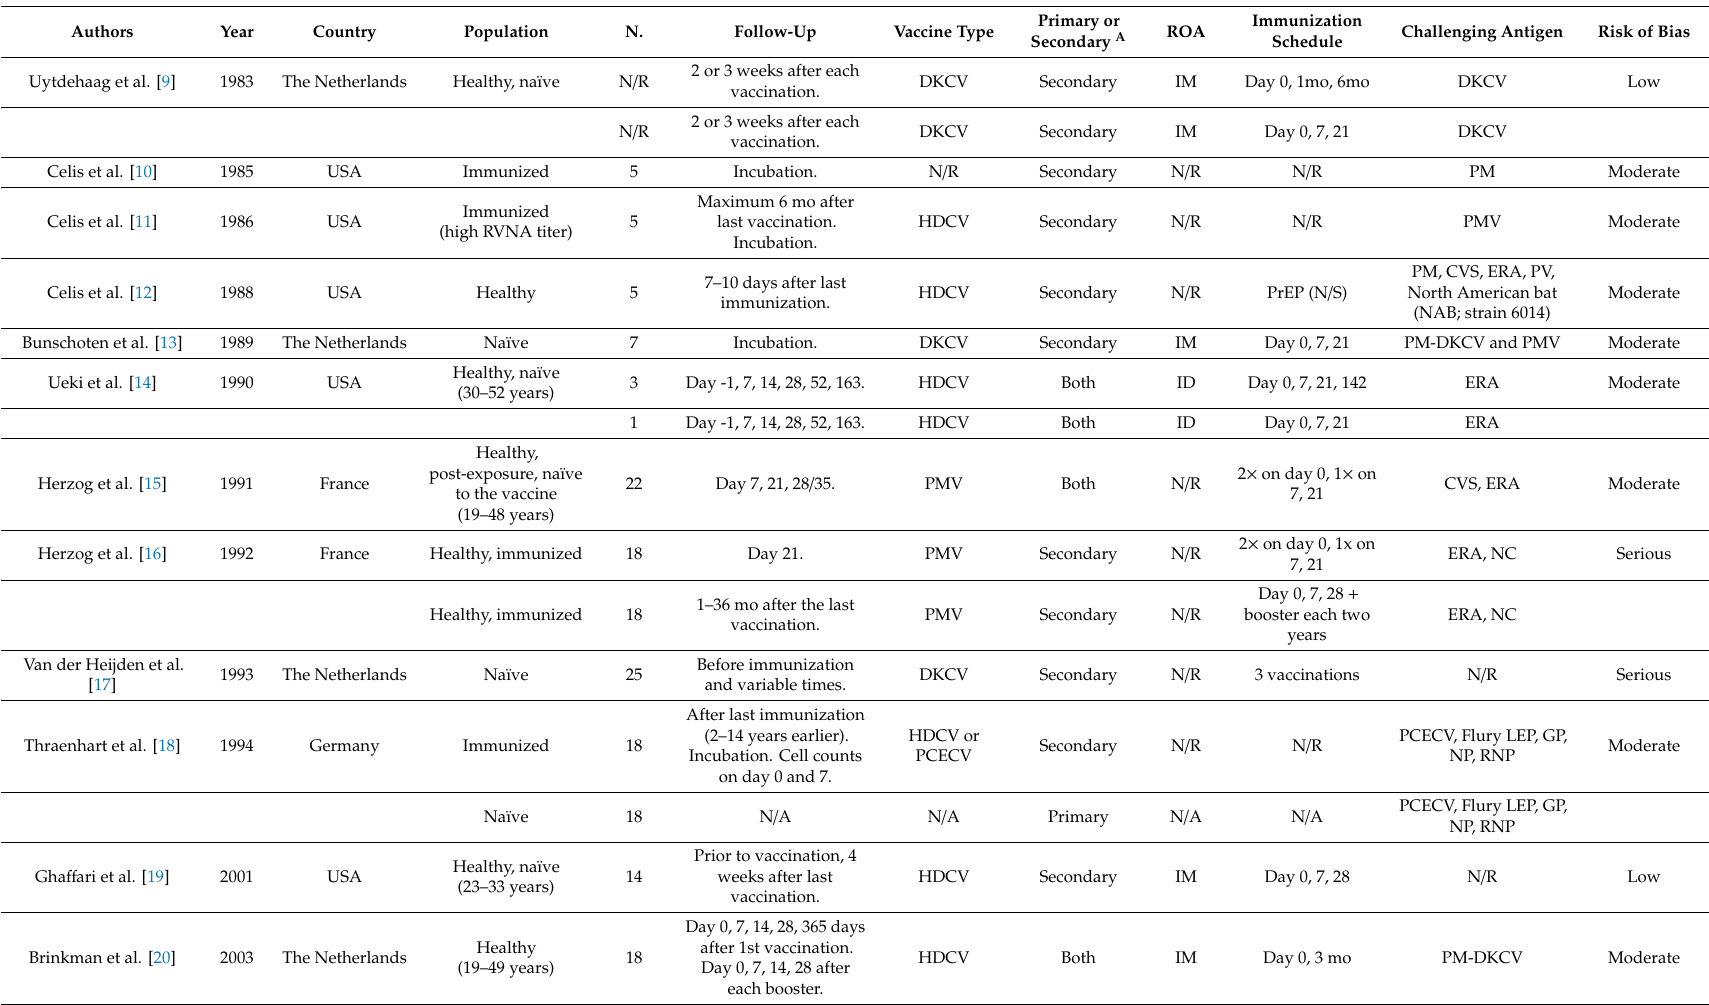
Table 1. Summary of included